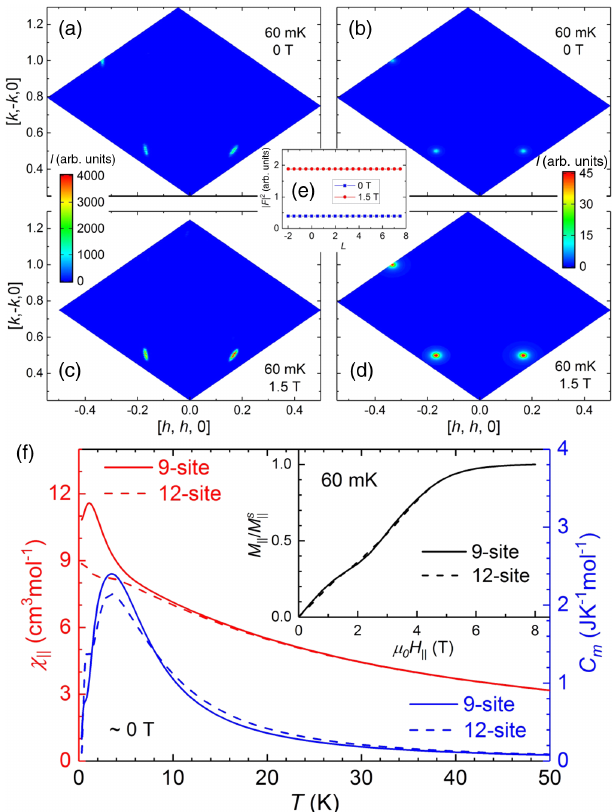
FIG. 13. Magnetic neutron diffraction of TmMgGaO 4 mea- sured at 60 mK in (a) 0 T and (c) 1.5 T. The calculated spectra are shown at (b) 0 Tand (d) 1.5 T using model no. 4 by Eq. (E3) with the magnetic form factor. The isotropic resolution is used in the momentum ( Q ) space, ∼ 0 . 015 in both (b) and (d). (e) Static structure factor per Tm calculated by model no. 4 [see Eq. (E3)] ; − 2 ; L (cid:4) at 0 and 1.5 T at 60 mK. (f) Thermodynamic along ½ 1 3 3 properties calculated on the 9-site (solid lines) and 12-site (dashed lines) clusters with different PBC. The same Hamiltonian parameters of the fitted model no. 2 are used. The red, blue, and black (in the inset) lines show the calculated dc susceptibility at 0.1 T (measuring field), heat capacity at 0 T, and magnetization at 60 mK,